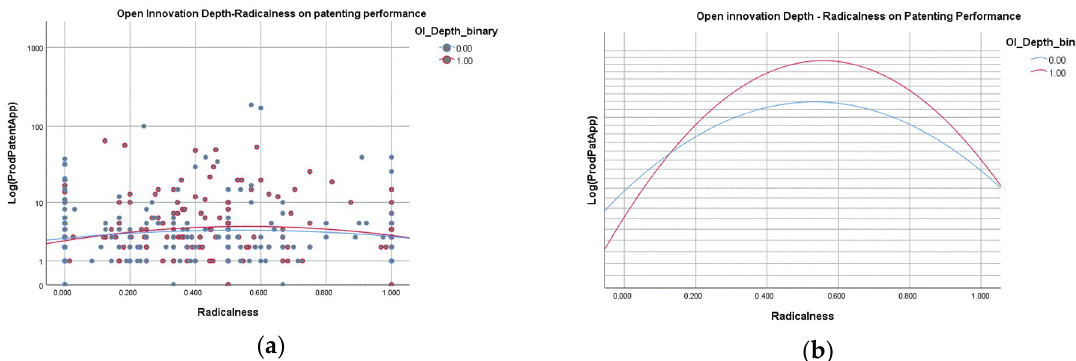
Figure 2. Inverted-U curve of patent application performance: positive open innovation depth vs. zero open innovation depth: ( a ) Log (Patent Application)-Radicalness; ( b ) simplified with fitting